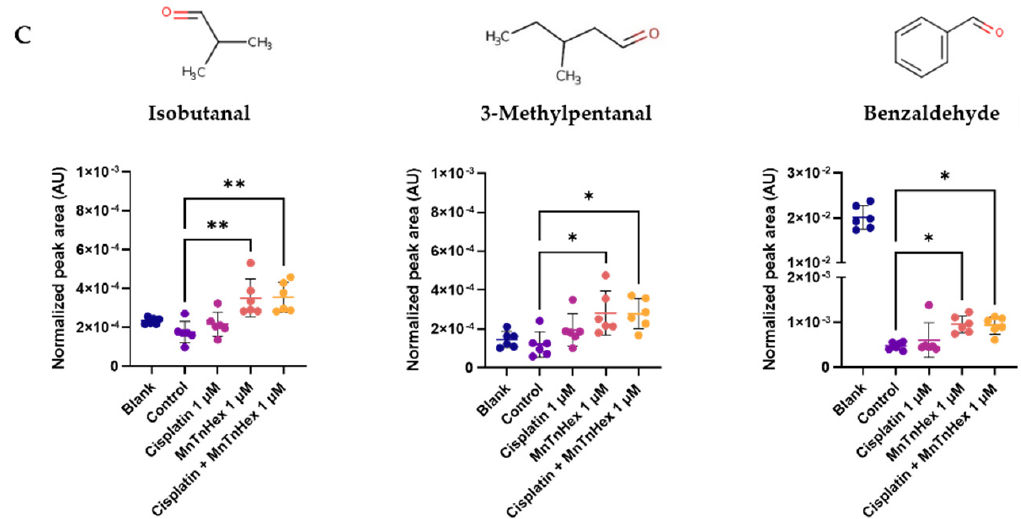
Figure 7. GC-MS-based metabolomics analysis of the extracellular media of H1975 cells exposed to MnTnHex and cisplatin, alone and combined. ( A ) Volcano plot of the GC-MS data of H1975 cells exposed to MnTnHex (1 µ M) 72 h compared with controls. ( B ) Volcano plot of GC-MS data of H1975 cells co-exposed to Cisplatin (1 µ M) and MnTnHex (1 µ M) compared with controls, indicating the statistical significance ( p -value) vs. the magnitude of change (fold change). Statistical significance was assessed using the Mann-Whitney test and p -values < 0.05 were considered significant. The grey dots indicate non-significant m/z-RT pairs, while the red dots indicate statistically significant m/z-RT pairs corresponding to isobutanal, 3-methylpentanal and benzaldehyde as marked. ( C ) Boxplots representing the normalized peak areas of the three significant VCCs. Statistical significance was assessed using the Kruskal-Wallis ANOVA test (* p < 0.05, ** p <